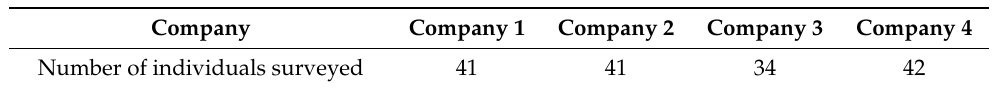
Table 6. Employees surveyed by